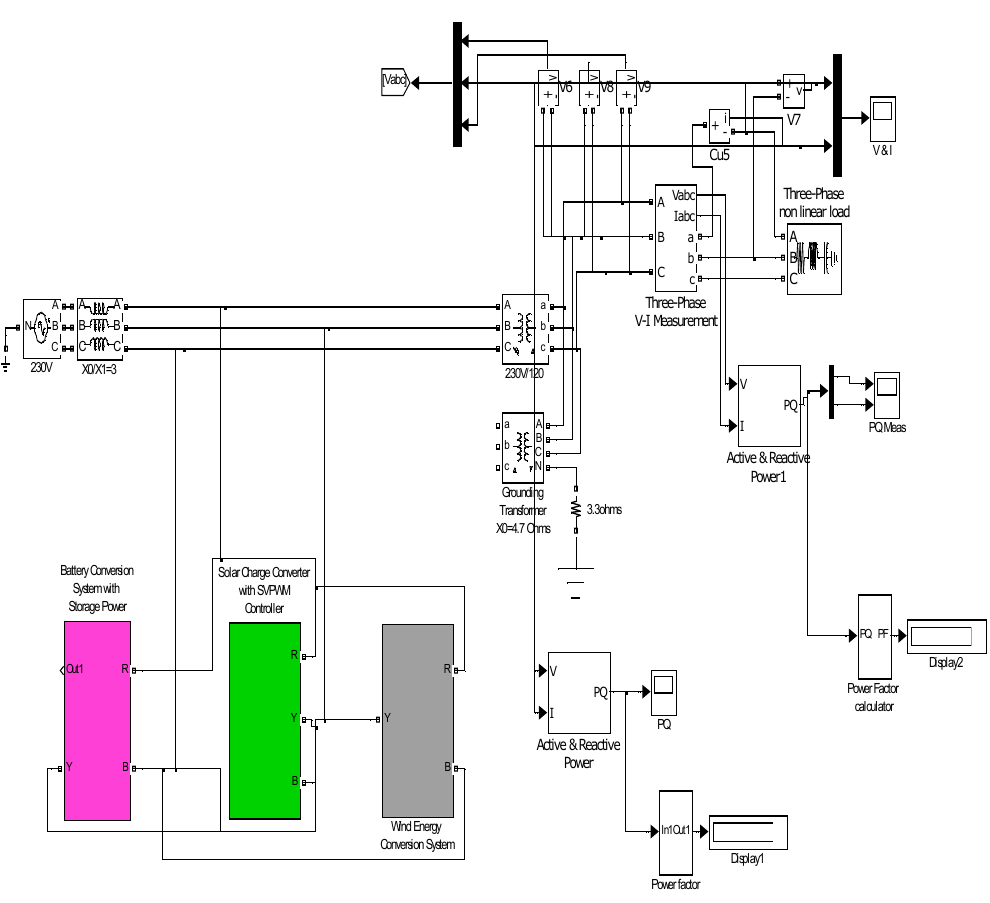
Figure 4. Microgrid simulation model. Table 1. Typical simulation scenarios with harmonic sources.